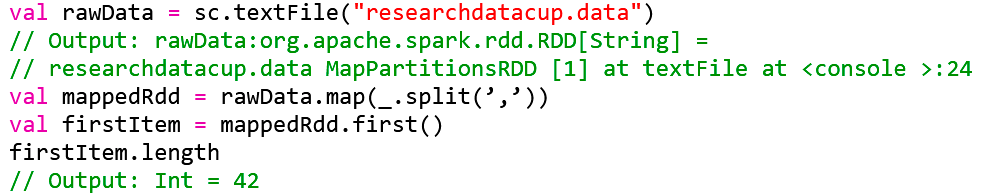
Figure 4. Analysis of data set in the Spark Shell.